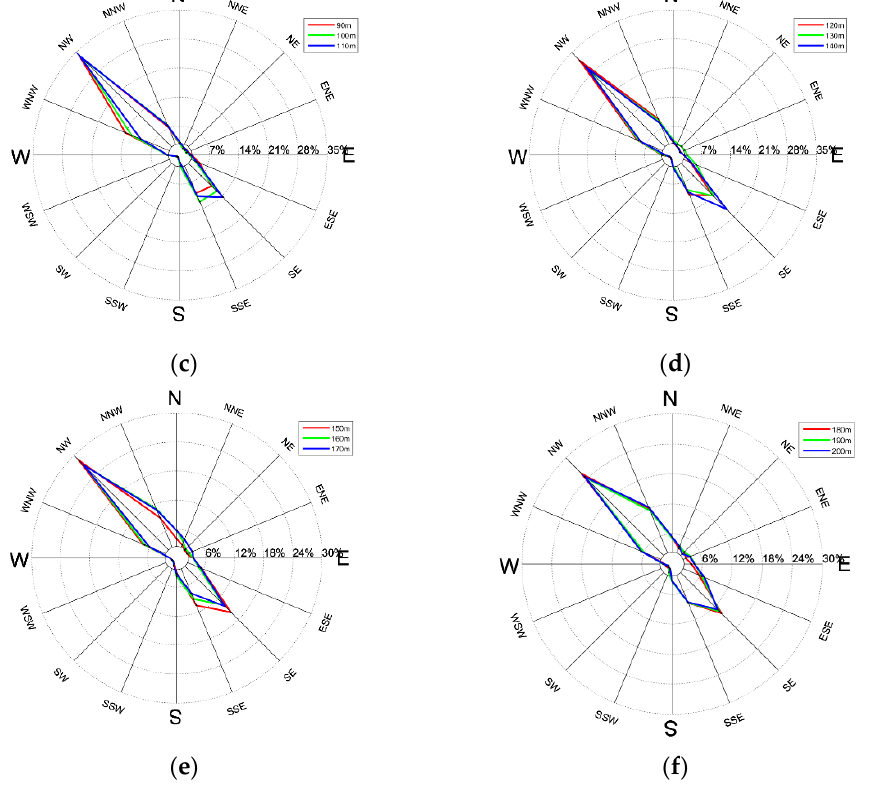
Figure 2. Wind direction rose diagram in the range of 30~200 m: ( a ) wind direction rose diagram from 30 m to 50 m; ( b ) wind direction rose diagram from 60 m to 80 m; ( c ) wind direction rose diagram from 90 m to 110 m; ( d ) wind direction rose diagram from 120 m to 140 m; ( e ) wind direction rose diagram from 150 m to 170 m; ( f ) wind direction rose diagram from 180 m to 200 m.